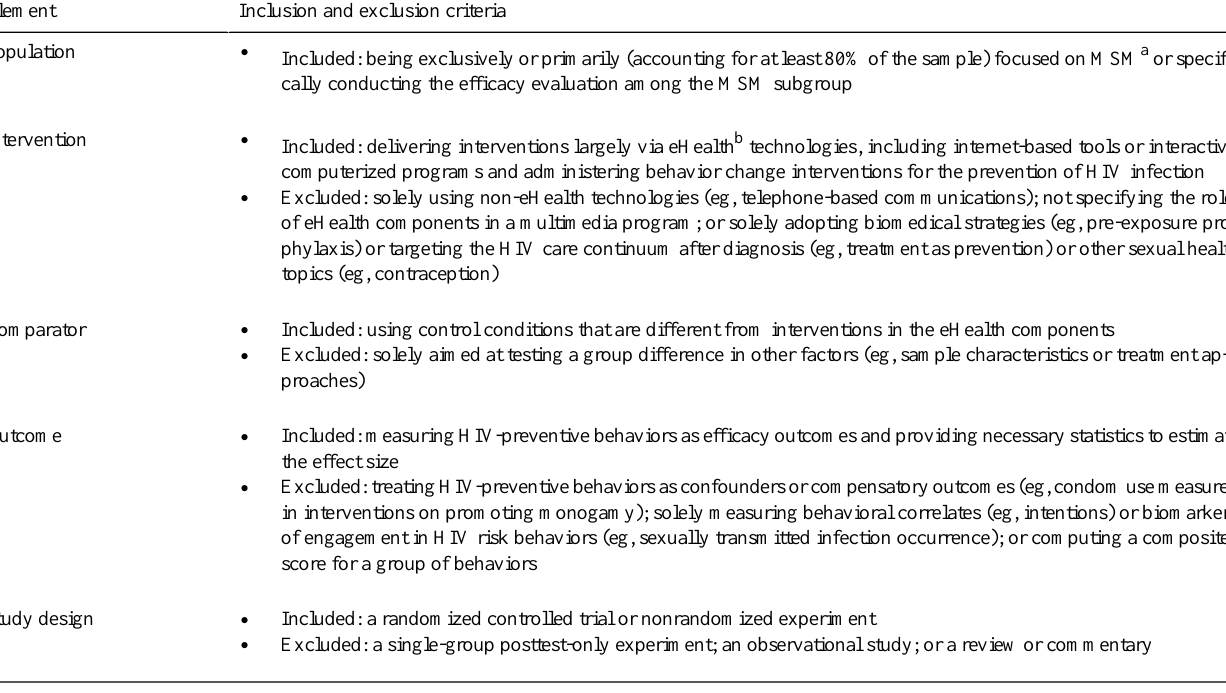
Table 1. Eligibility criteria for elements of a comprehensive search strategy.